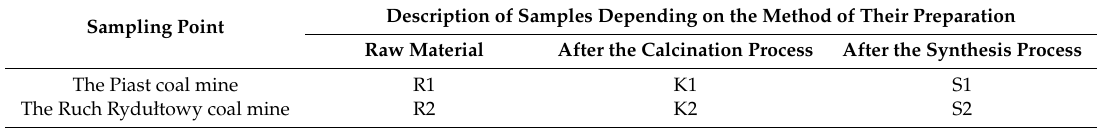
Table 1. Description of samples depending on the sampling point and the treatment